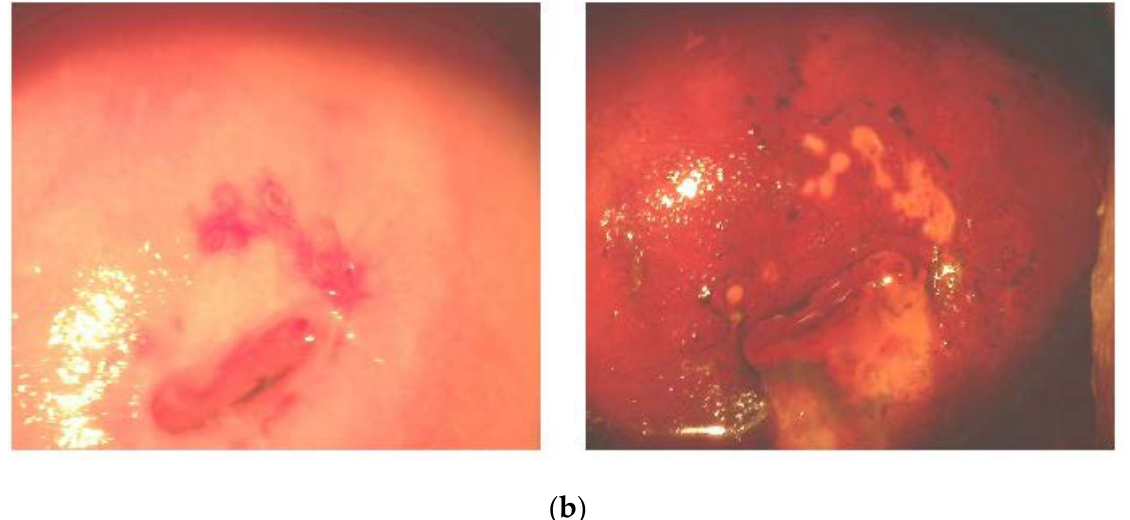
Figure 5. Typical colposcopy of CIN I and CIN II lesions before ( a ) and after ( b ) administration of antioxidants. ( a ) Before administration of antioxidants (ectopic transformed areas, squamous cell metaplasia, and mosaics marked by the iodine-negative areas). ( b ) After a three-month course of antioxidants (normal tissue basis, shrinkage of iodine-negative areas, and cervical coagulation). Left panels are colposcopic images without iodine staining. Right panels are colposcopic images after iodine staining.